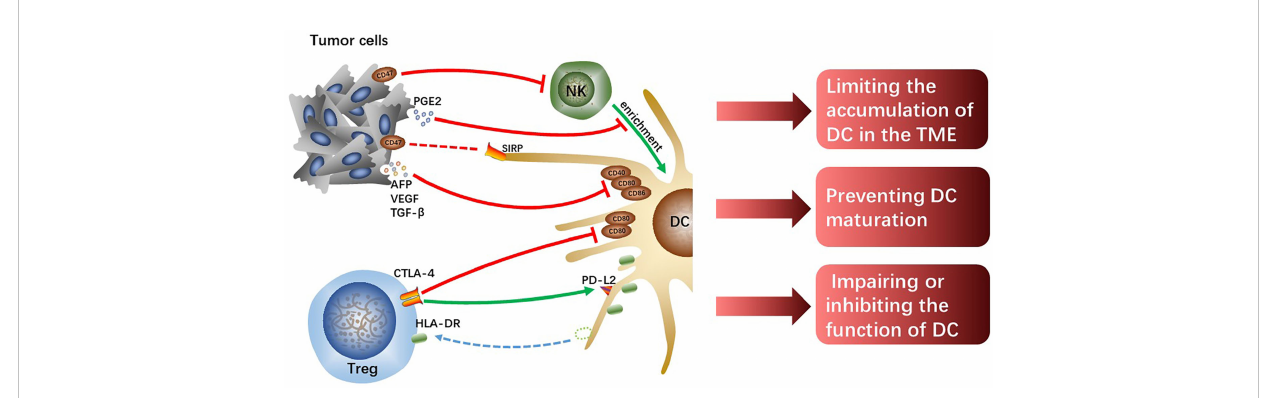
FIGURE 2 The tumor cells or Tregs interacting with DCs limit the accumulation of DCs, prevent DCs maturation and attenuate their function, which hinders the initiation of effectively anti-tumor